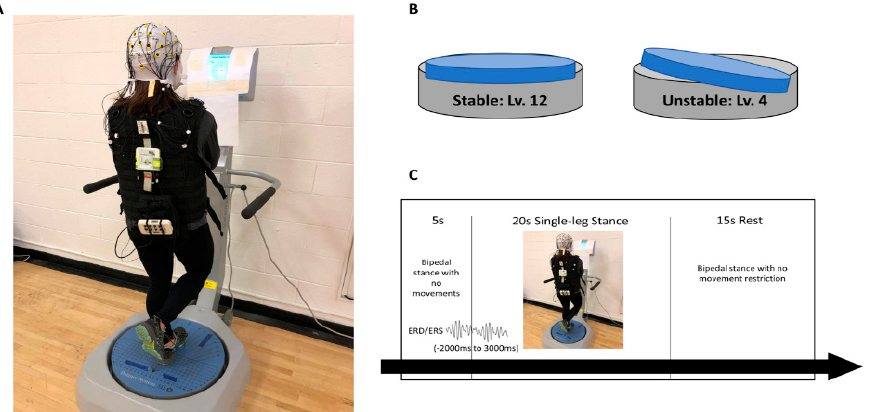
Figure 1. ( A ) Experimental setup. Visual feedback indicating participants’ center of pressure was presented in a display. ( B ) Postural control conditions: stable (level 12) and unstable (level 4). ( C ) Single trial of postural control experimental sequence.